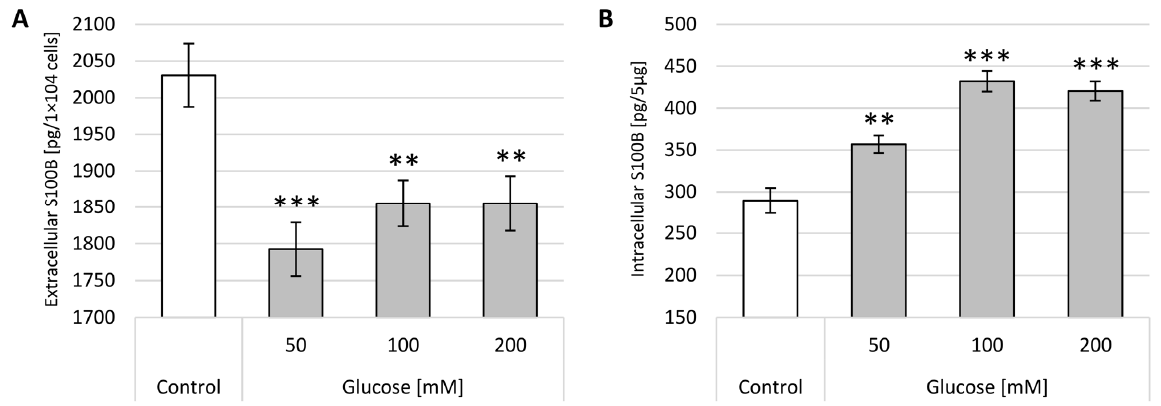
Figure 6. S100B protein concentration in neuron-like cells after incubation with different glucose concentrations (50, 100 and 200 mM). Control—untreated cells. ( A ) extracellular S100B levels per 1 × 10 4 cells; ( B ) intracellular S100B levels per 5 µg of total cellular protein concentration. Statistically significant differences compared to the untreated neuron-like cells: ** p < 0.01, *** p < 0.001.